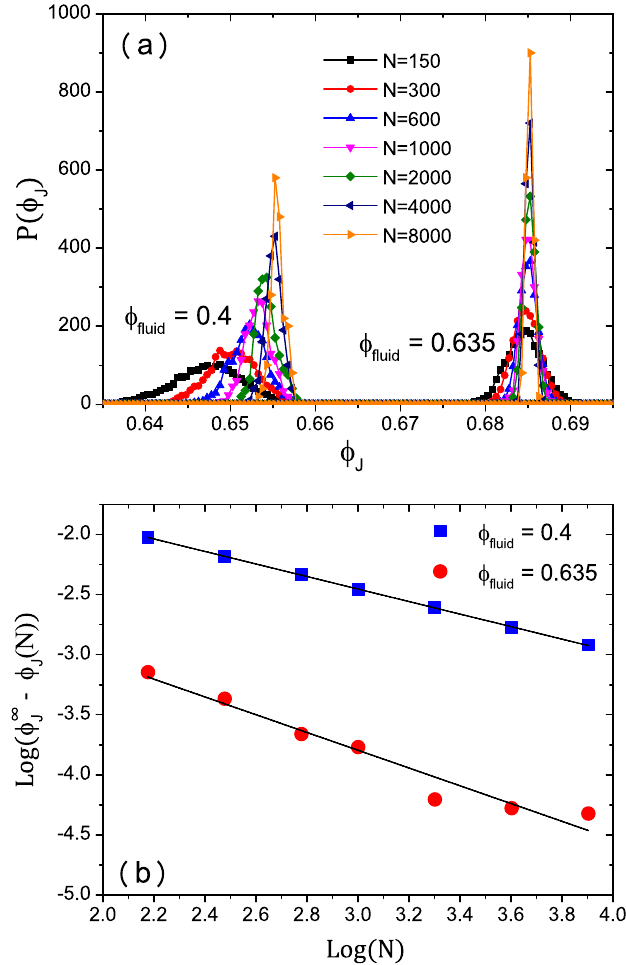
Figure 10: (a): Probability distribution function of φ for several N obtained by compressing J = 0.4) and dense ( φ = 0.635) equilibrium fluid configurations. (b): Finite- dilute ( φ fluid fluid ( N ) are considerably size scaling plot according to Eq. (7). Finite-size effects on the quantity φ J = suppressed for φ fluid